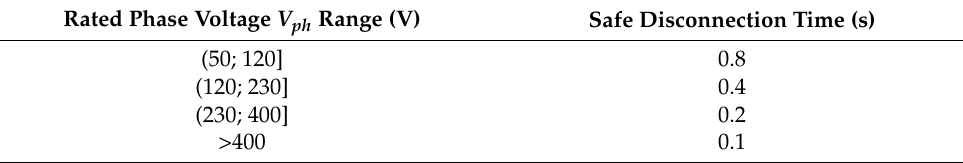
Table 1. Safe disconnection time in TN low-voltage network.